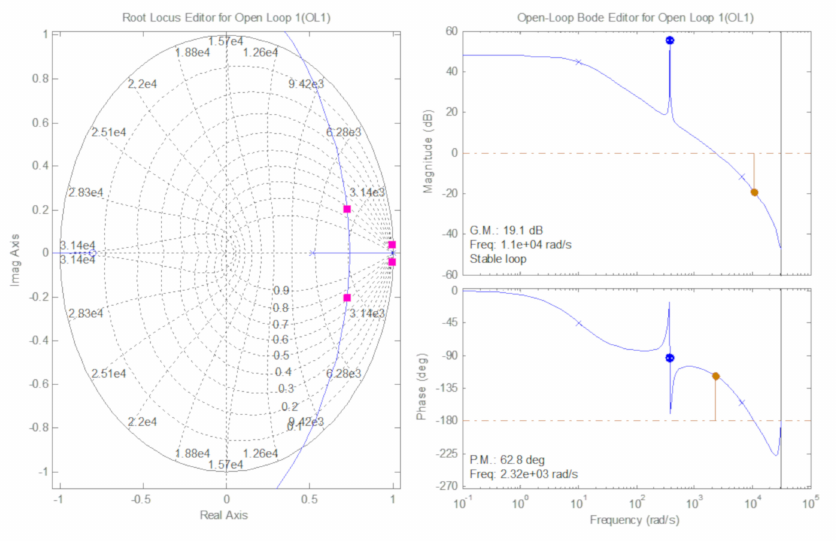
Figure 13. Zero-pole map and the open-loop Bode plot of the PR current control.